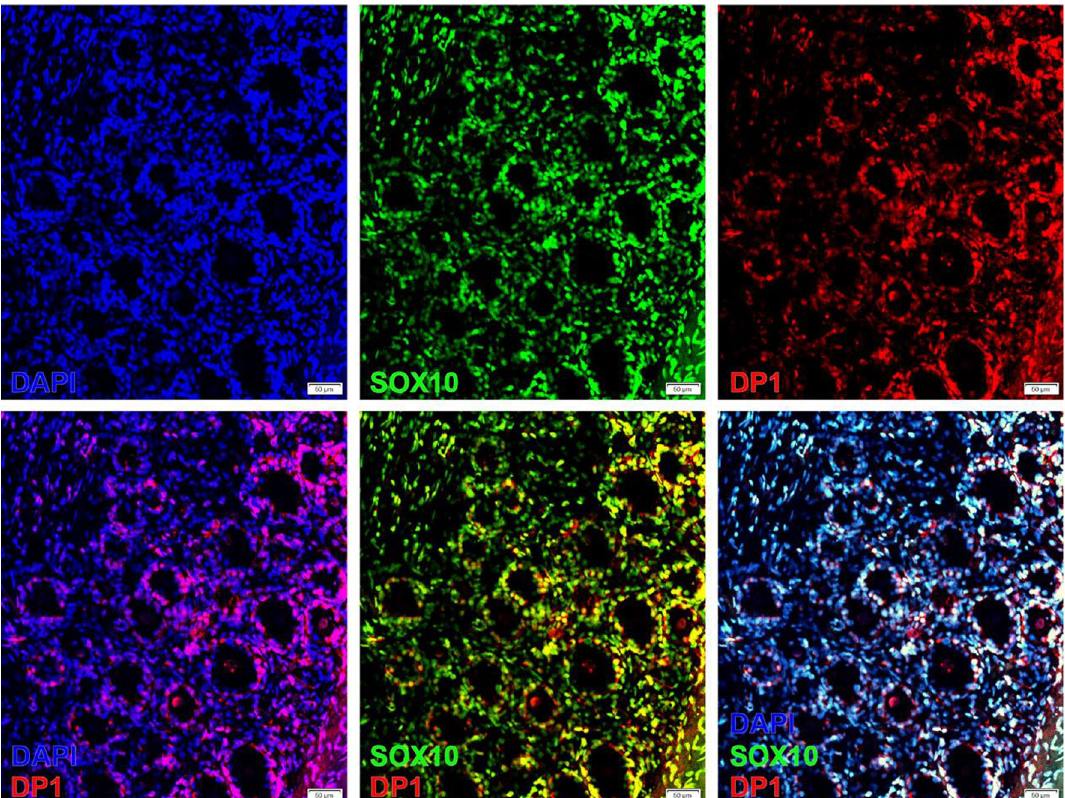
Figure 4. PGD2 receptor, DP1, is expressed in cells surrounding human DRG neurons. DP1 (red) is co-localized with SOX10+ (green) cells in human DRG. Cell nuclei are labelled with DAPI (blue). Scale bar = 50